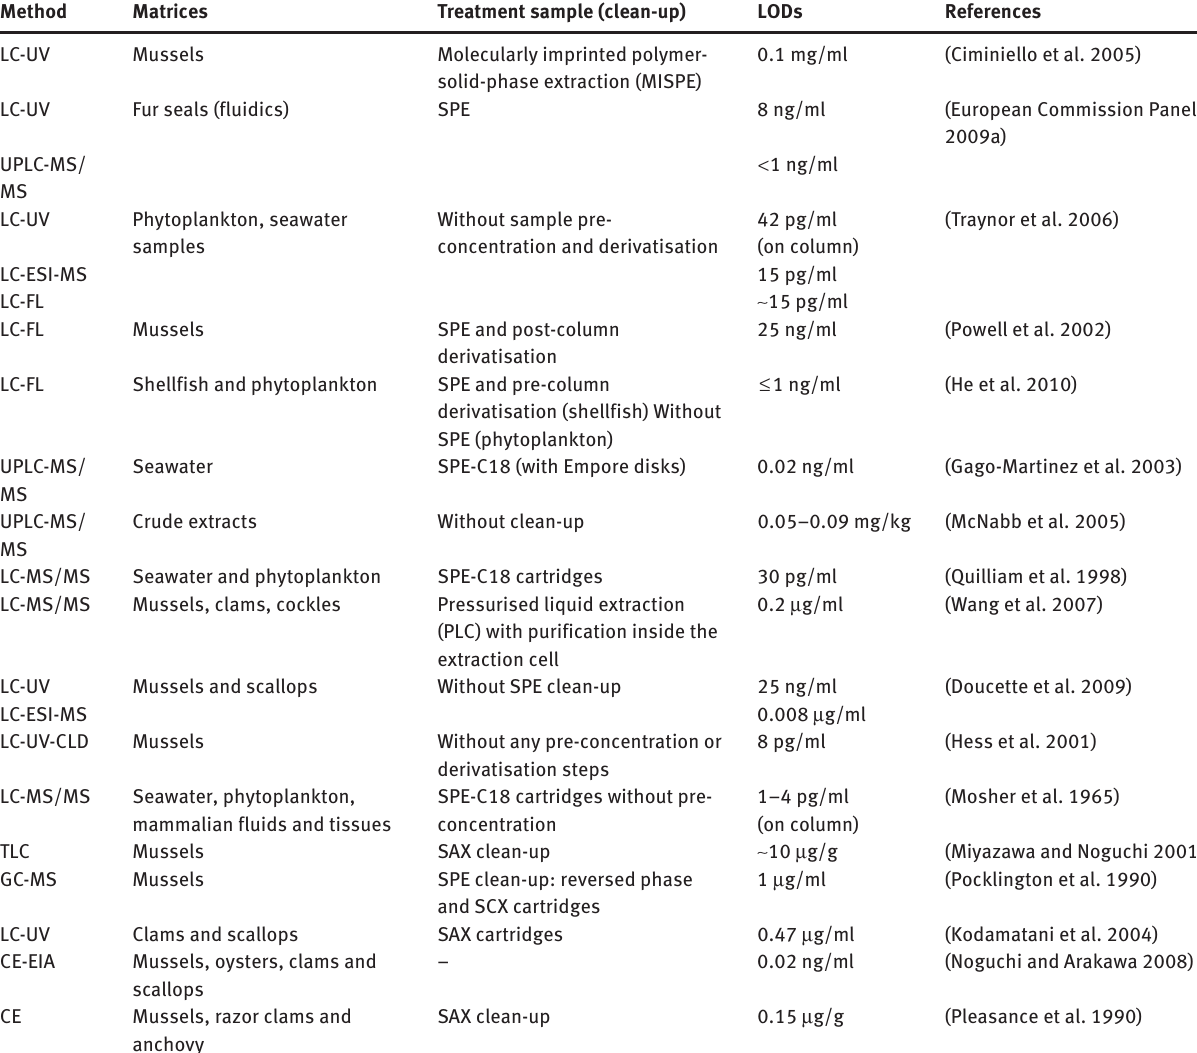
Table 1 Some representative analytical chemical methods for the detection of DA in a range of matrices. CE, capillary electrophoresis; CE-EIA, capillary electrophoresis-enzyme immunoassay; DA, domoic acid; EIA, enzyme immunoassay; GC-MS, gas chromatography-mass spectrometry; LC-ESI-MS, liquid chromatography-enzyme immunoassay-tandem mass spectrometry; LC-FL, liquid chromatography with fluorescence detection; LC-MS/MS, liquid chromatography with tandem mass spectrometry; LC-UV, liquid chromatography with ultraviolet detection; LC-UV-CLD, liquid chromatography-ultraviolet-chemiluminescence detection; LODs, limits of detection; SAX, strong anion exchange; SCX, strong cation exchange; UPLC-MS/MS, ultraperformance liquid chromatography with tandem mass spectrometry; TLC, thin layer